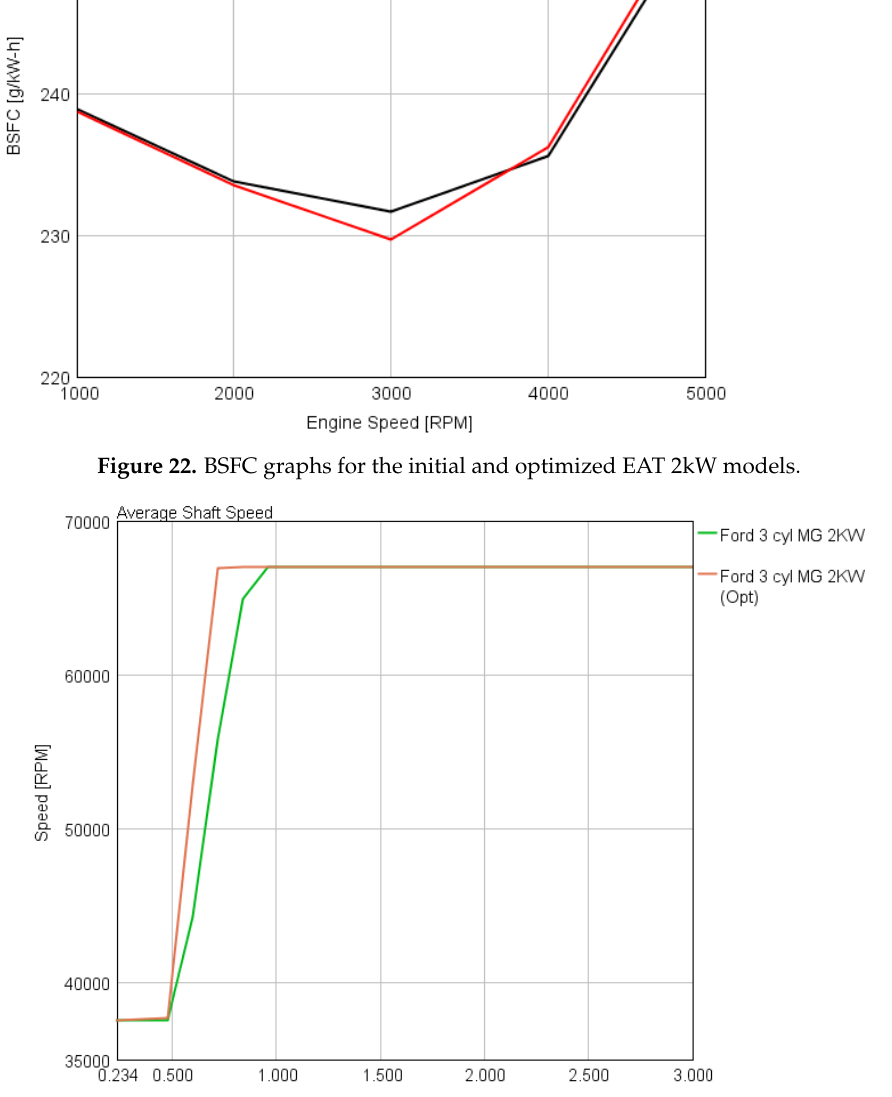
Figure 23. Average Shaft speed of the electrically-assisted turbocharger (EAT) models with 2 kW power level at 1,000 rpm engine